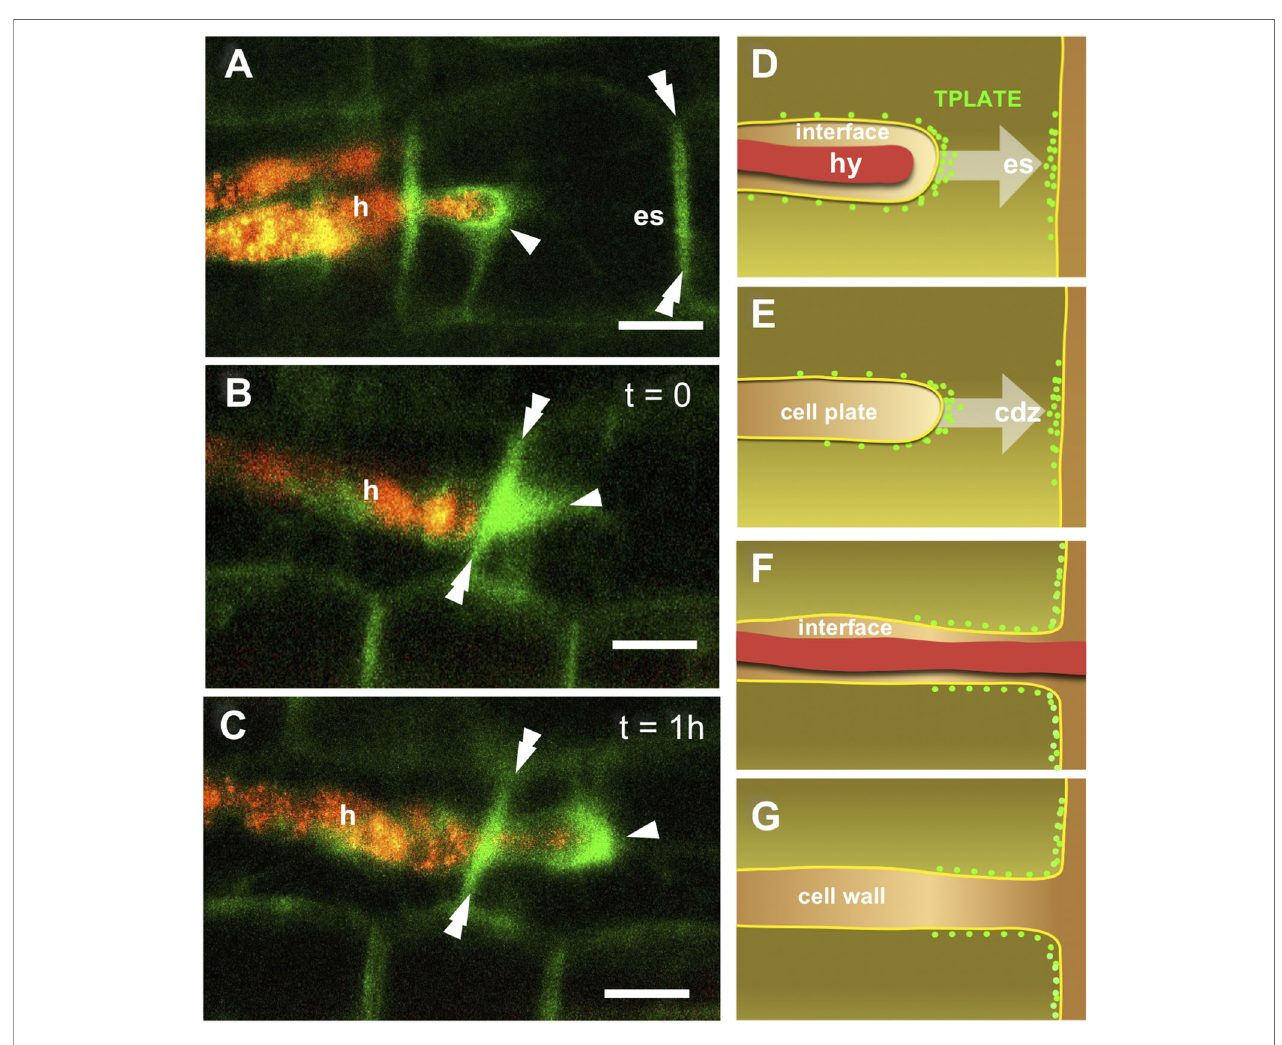
FIGURE 4 | TPLATE-GFP labeling of cell-to-cell hyphal passage in the outer cortex. An intense GFP signal (arrowhead) is visible in (A) , around the tip of an intracellular hypha (h). This is associated with the accumulation of TPLATE-GFP along the wall (double arrowheads) that separates the colonized cell from the adjoining uncolonized cell, in the area of the predicted hyphal exit site (es). An elongated PPA (arrowhead) is visible in an uncolonized cell on the right side of panel (B) ; the hypha growing in the cell on the left has reached the cell wall, where an intense GFP signal has accumulated (double arrowheads). The same site is pictured in (C) 1 h later: The hypha has now penetrated the cell on the right; a bright signal surrounds the hyphal tip (arrowheads) and a strong fl uorescence is still visible along the cell wall (double arrowhead). Bars = 30 µm. Panels ( D – G ) show a schematic view of the analogies between perifungal membrane (D , F) and cell plate (E , G) fusion with the peripheral plasma membrane. In both cases, TPLATE accumulation was observed at the front of the developing compartment (D , E) , and at the exit site (es) or cortical division zone (cdz), respectively. Following membrane fusion (F , G) , TPLATE diffuses at the junction between the two